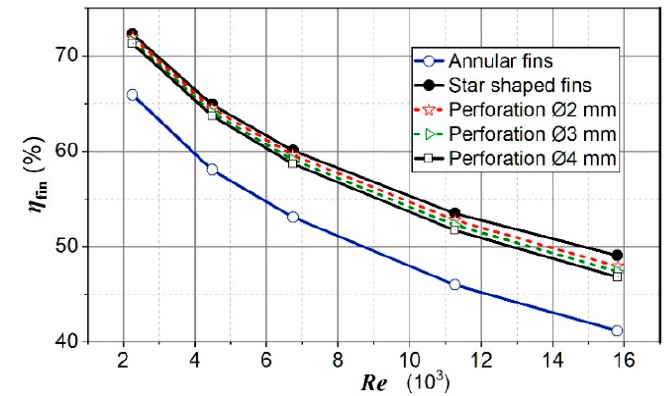
Figure 13. Fin e ffi ciency for analyzed cases. Figure 13. Fin efficiency for analyzed cases.